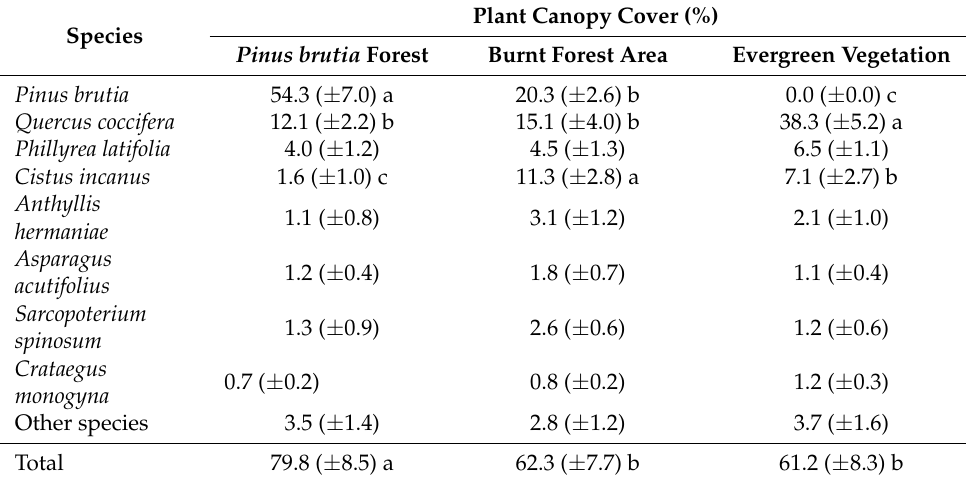
Table 4. Canopy cover (%) of the dominant woody species in the three types of vegetation. Values represent means and standard errors of mean. Values in the same row followed by different letters indicate significant differences between them.